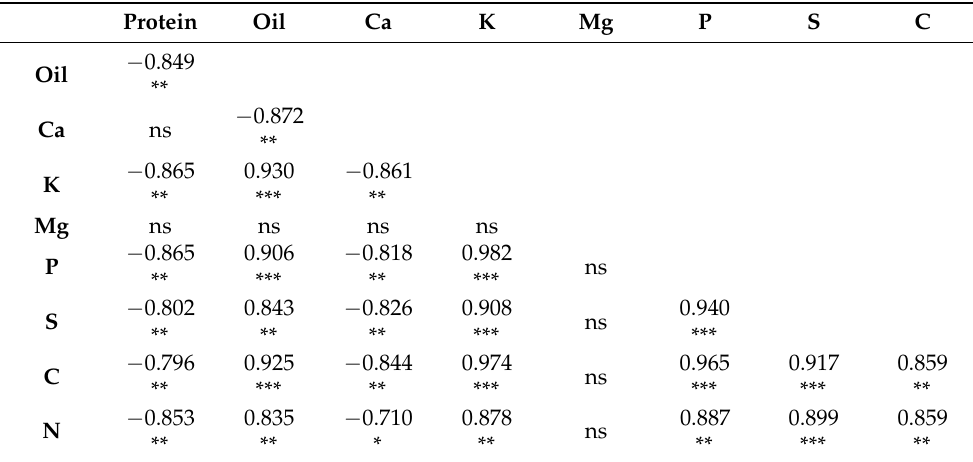
Table 5. Pearson correlation coefficients (P and R values) between seed nutrients in the near-isogenic lines (Uzbek curly leaf, DP 5690 wild type, and DP 5690 curly leaf) cotton in 2015. The experiment was conducted in Stoneville, MS, USA. Protein Oil Ca K Mg P S